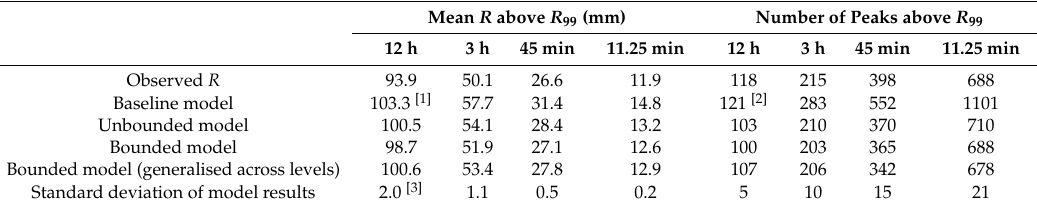
Table 4. Observed and simulated mean R above R 99 and the number of R above R 99 over 1908–2015. Mean R above R 99 (mm) Number of Peaks above R 99 Observed